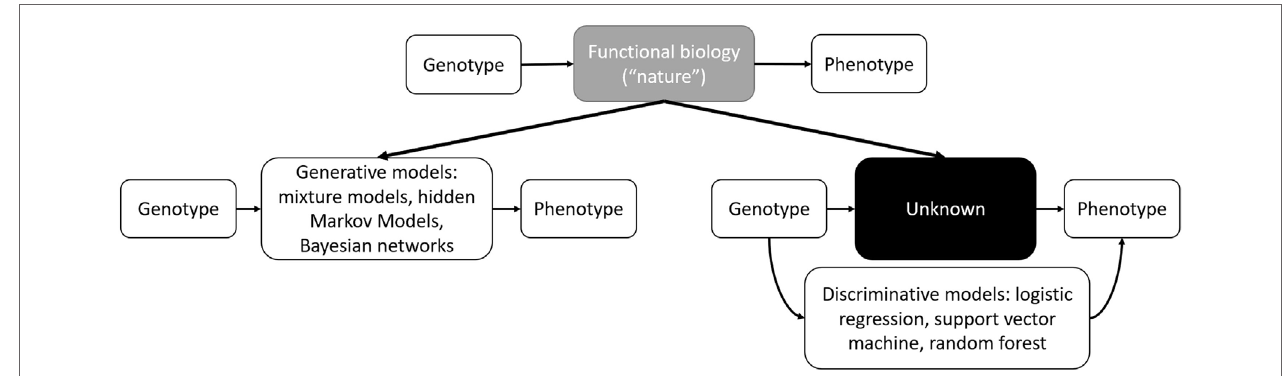
FiGURe 1 | Schematic outline of functional biology modeling via generative or discriminative